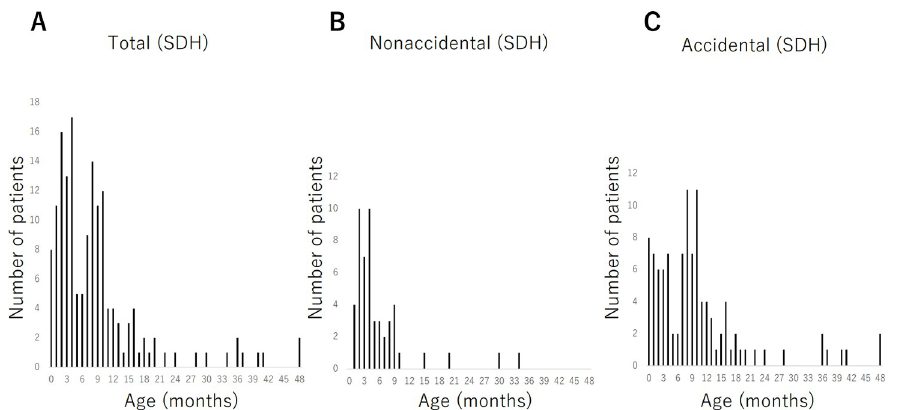
Fig 2. Age distribution of patients with subdural hematoma. A: Total, B: Nonaccidental, C: Accidental. There is a peak at 2 to 4 of months of age in the nonaccidental group and another peak at 8 to 10 of months of age in the accidental group.